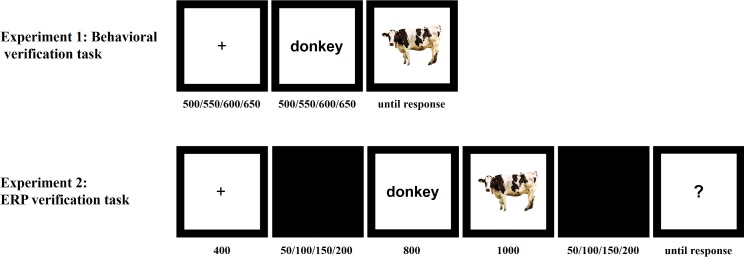
Structure of an experiment trial.